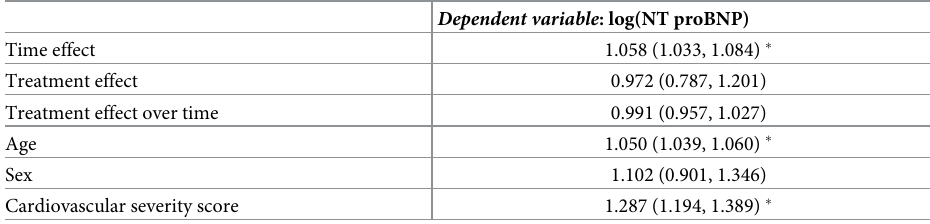
Table 2. Mixed model estimates.